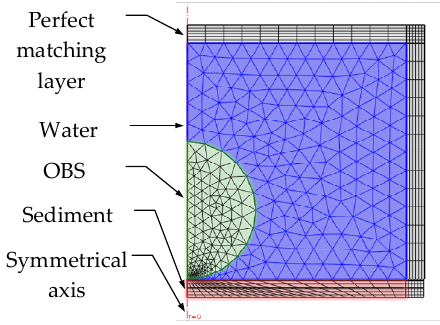
Figure 11. Axial symmetry model of an OBS placed on the seafloor. Table 3. Material parameters of sediment.